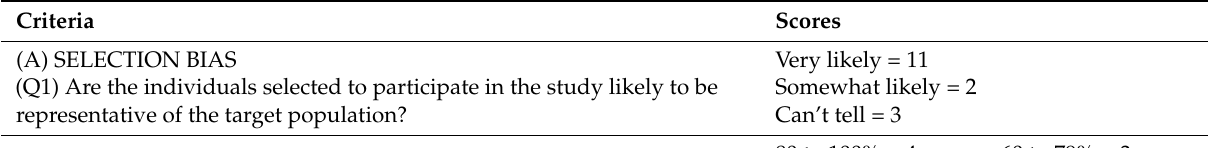
Table A1. Results of the quality